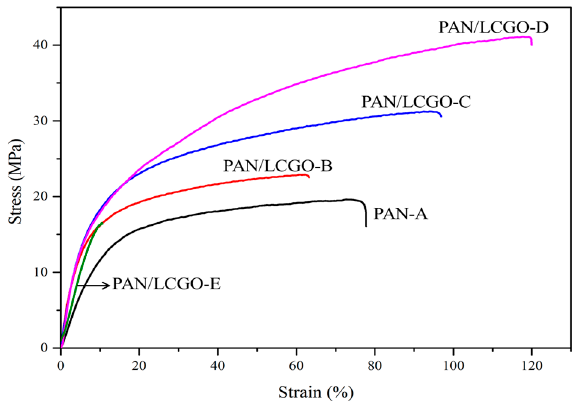
Figure 7. Stress vs. strain curves for as-prepared electrospun twisted PAN and PAN/LCGO yarns.